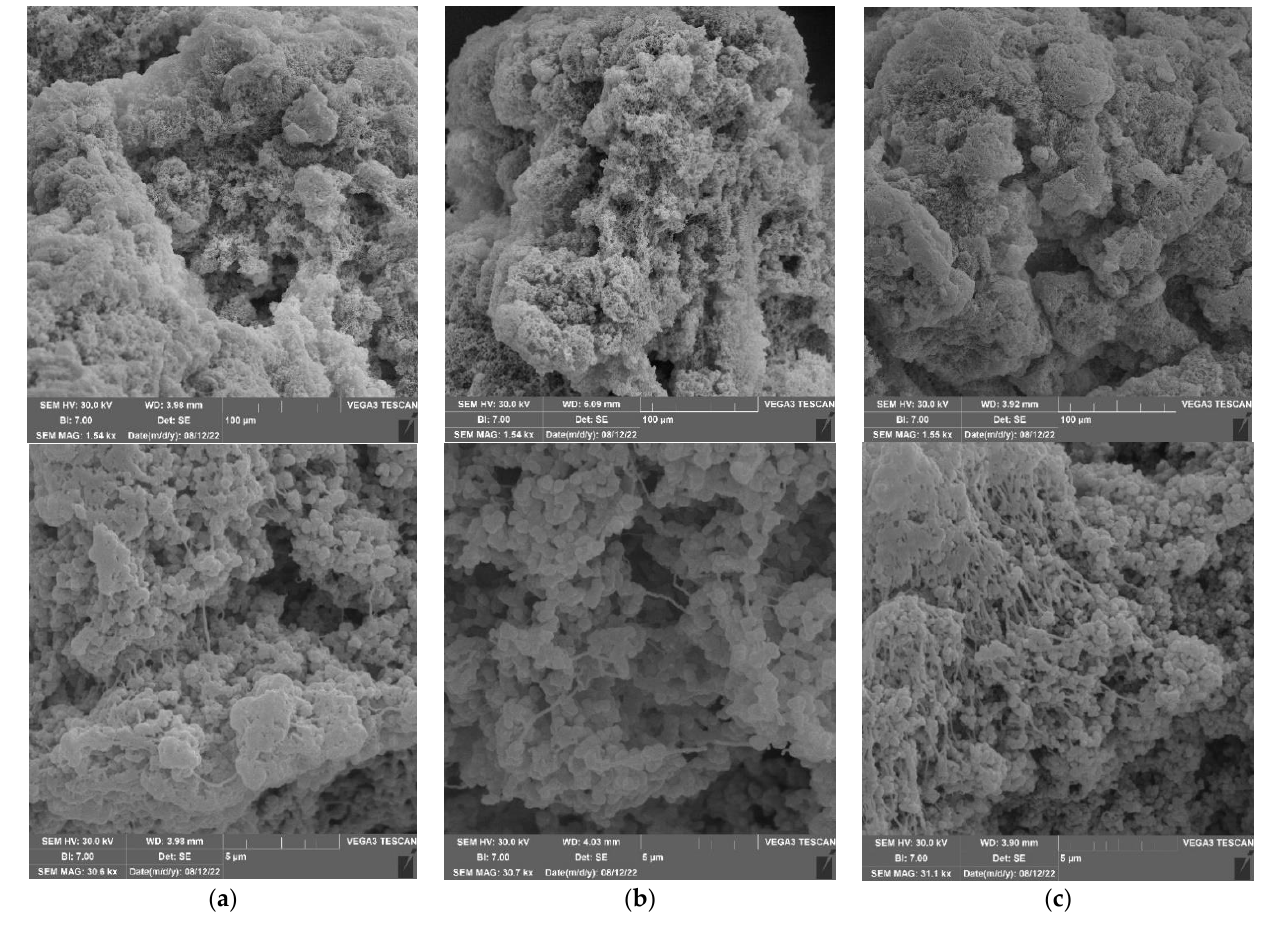
Figure 3. SEM images of the surface morphology of UHMWPE powders obtained with catalytic system 1 /Et 2 AlCl+Bu 2 Mg (( a ), entry 1); 1 /EtAlCl 2 +Bu 2 Mg (( b ), entry 4); and 1 /Et 3 Al 2 Cl 3 +Bu 2 Mg (( c ), entry 3) in nefras.